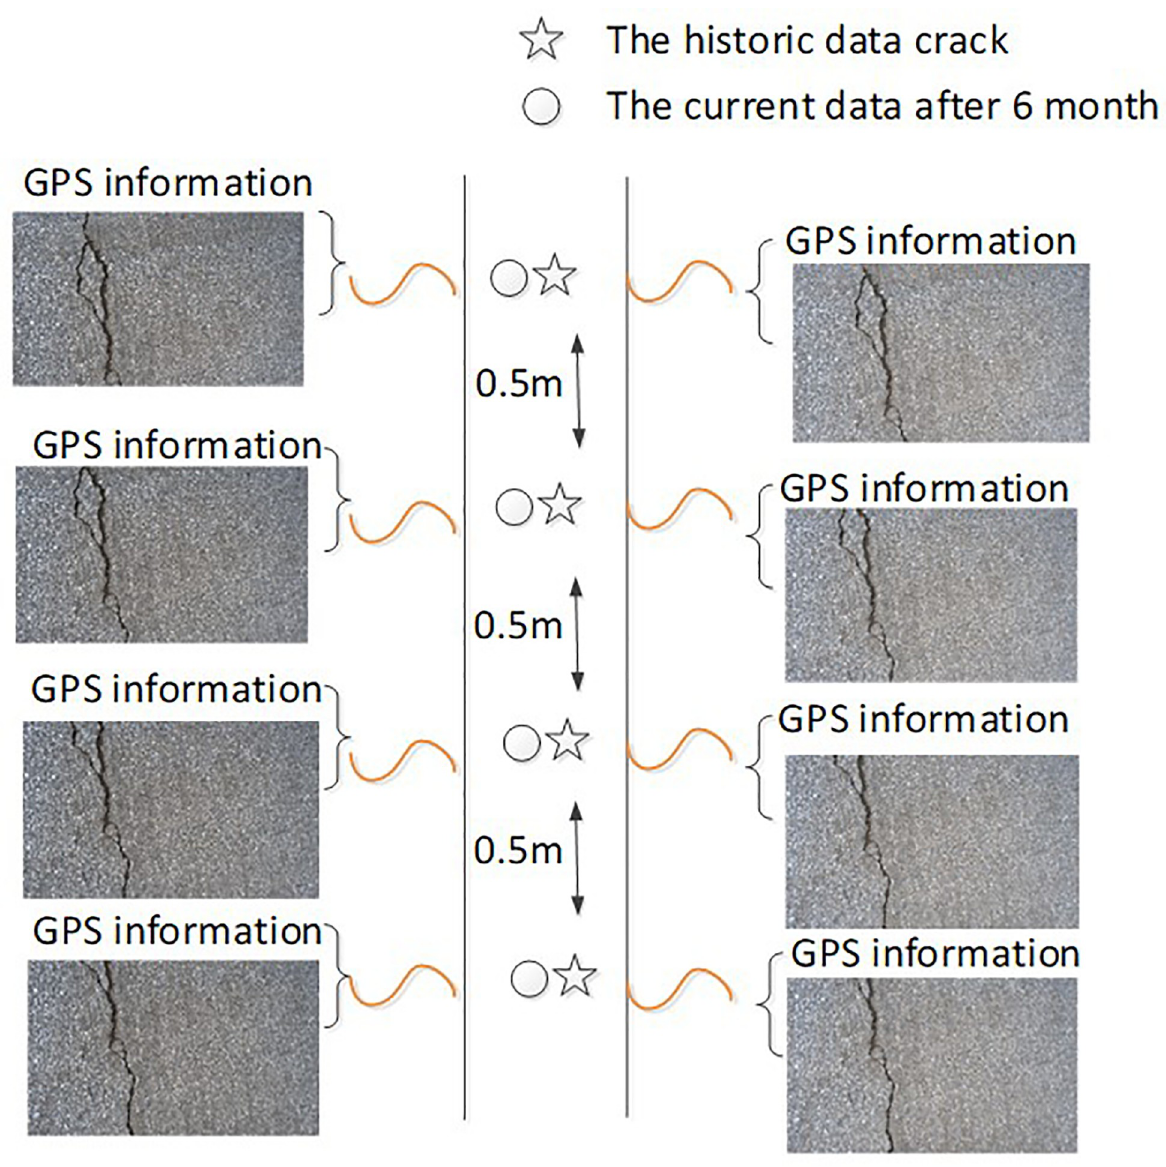
Fig 7. The organization form of query data and historical